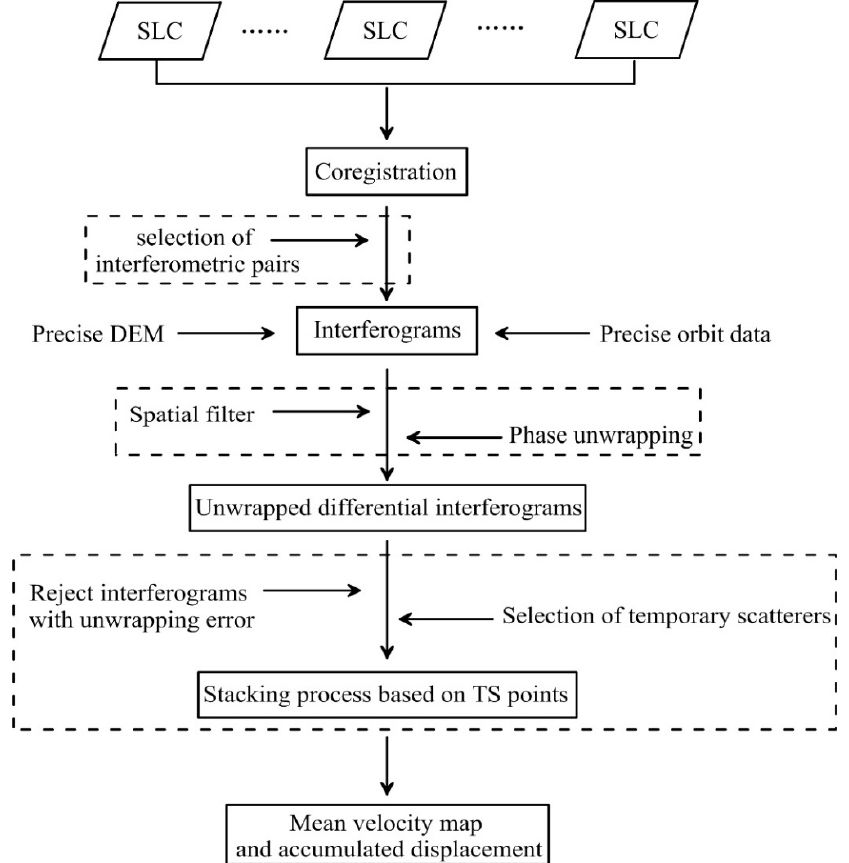
Figure 2. The flowchart of temporary scatterers stacking InSAR method.